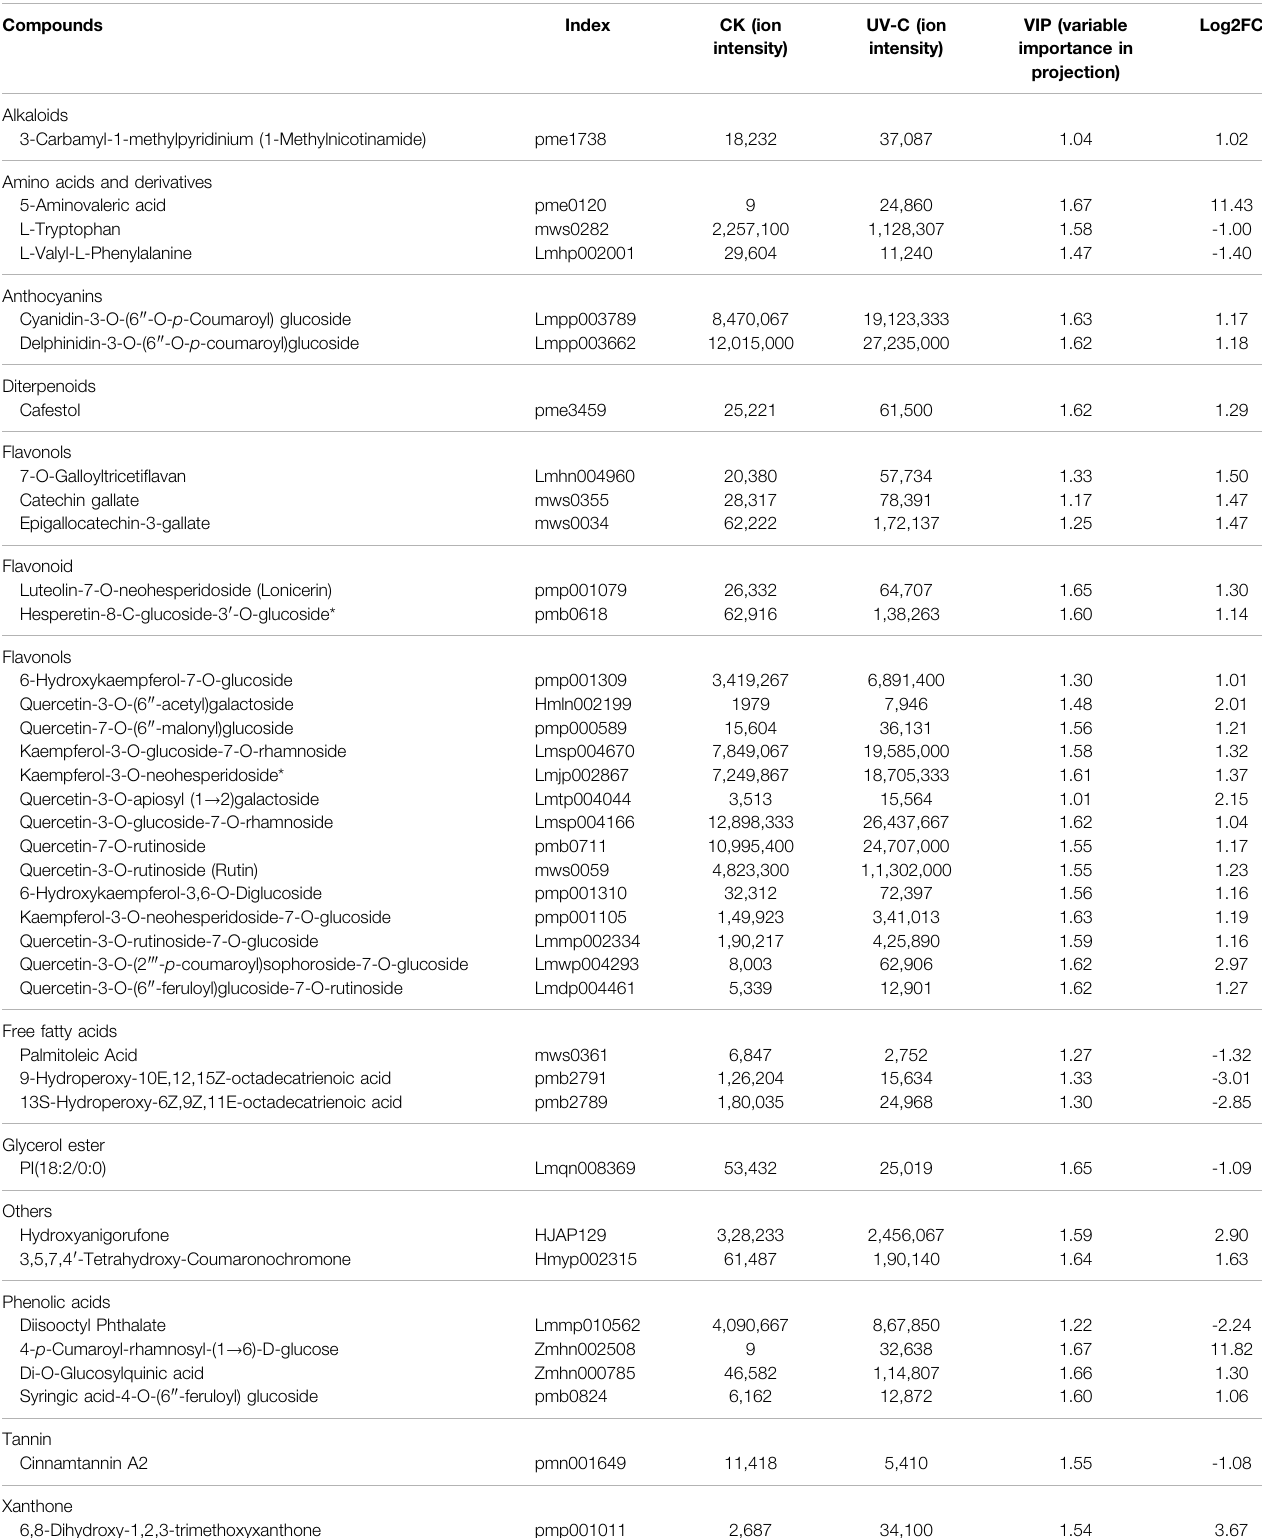
TABLE 1 | List of metabolites that were differentially accumulated in Musa nana peel before and after UV-C treatment.